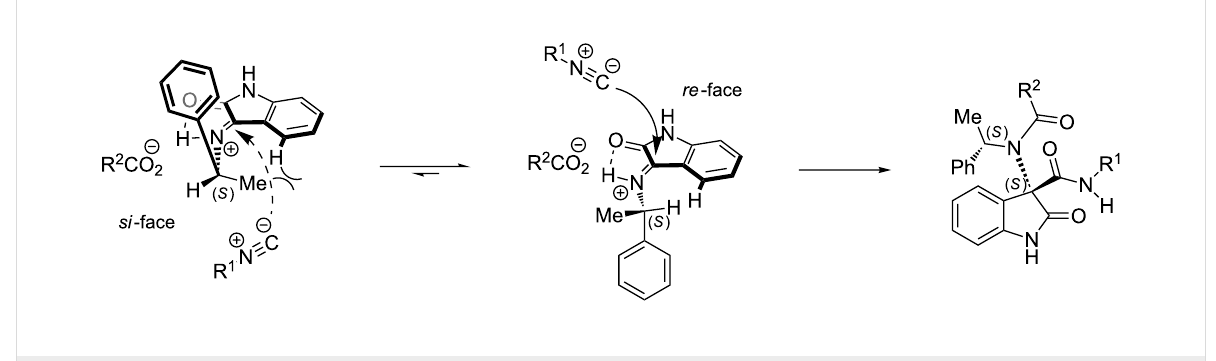
Figure 3: Proposed explanation of the stereochemical outcome of the Ugi 3CR.